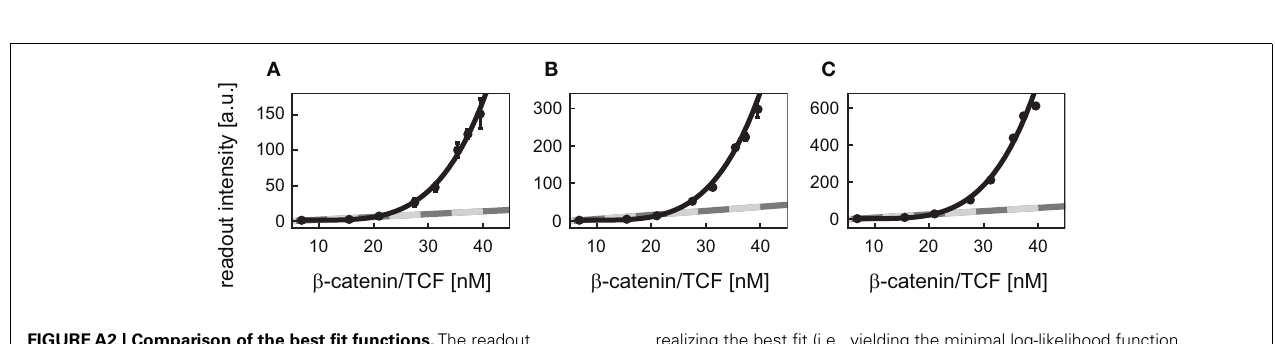
realizing the best fit (i.e., yielding the minimal log-likelihood function values) are shown for each reporter construct. Note, that the fits of the linear and the Michaelis–Menten activation lie on top of each other.The experimental data was kindly provided by Biechele and Moon